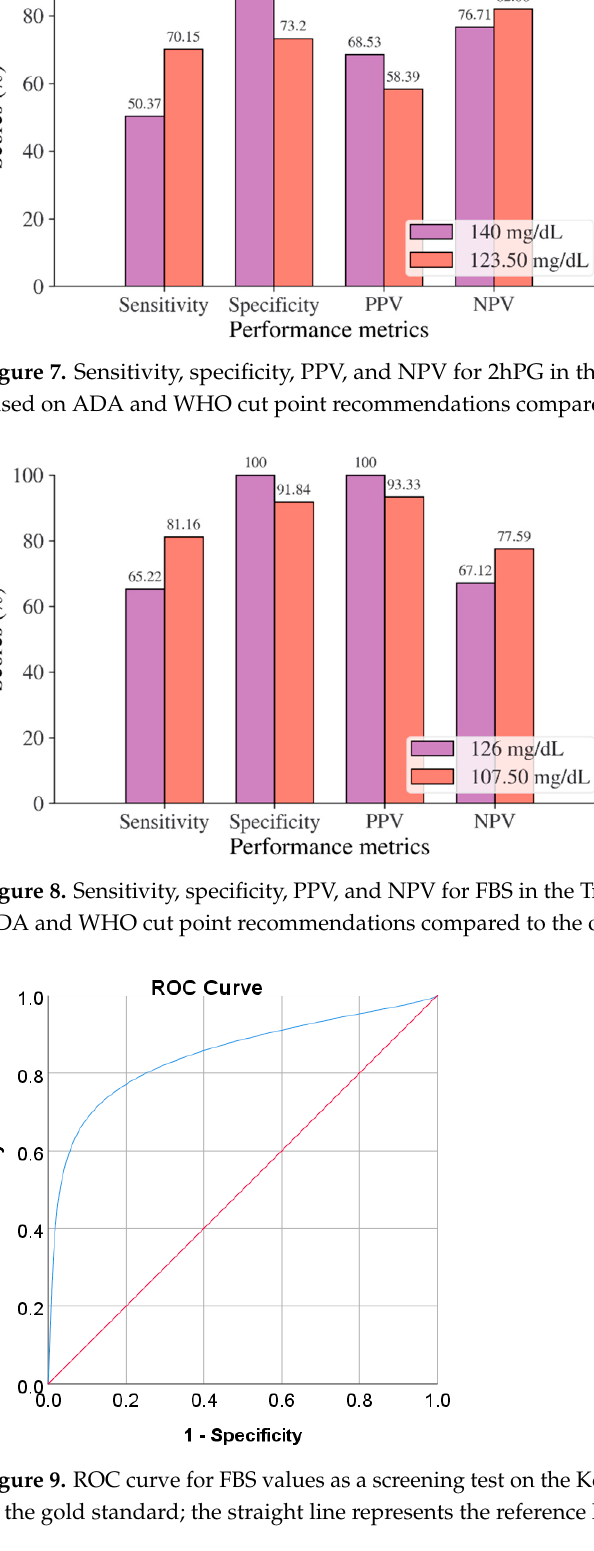
Figure 10. ROC curve for 2hPG values as a screening test on the US-PIMA Indian adult population; 2hPG was used as the gold standard; the straight line represents the reference line.